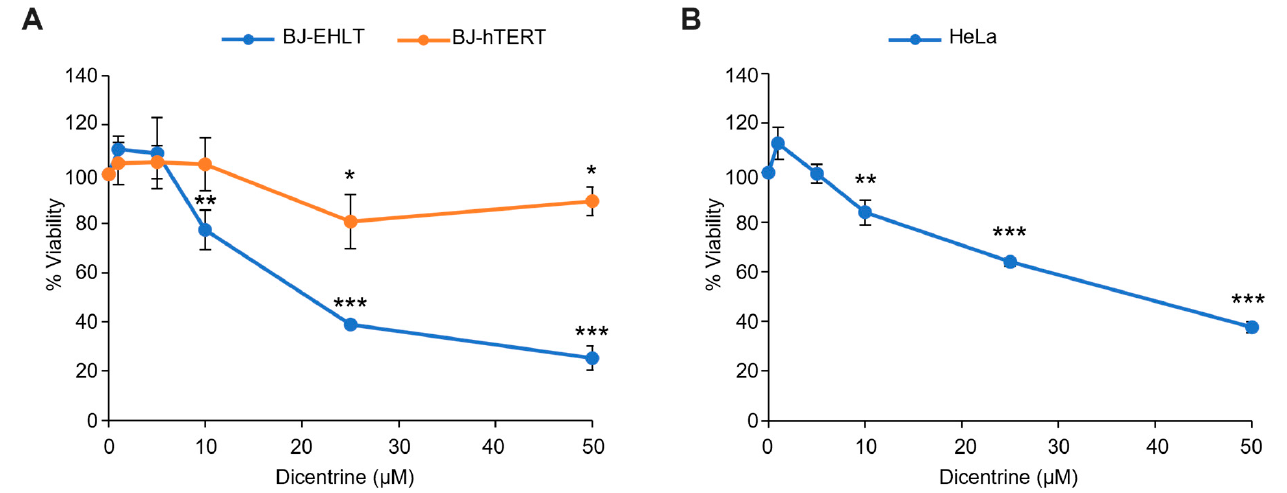
Figure 9. Effect of Dicentrine on cell viability. ( A ) BJ-EHLT (blue line) and BJ-hTERT (orange line) fibroblasts or ( B ) HeLa cells were treated for 72 h with increasing doses of Dicentrine (1, 5, 10, 25 and 50 µ M) or with DMSO (negative control). Cell viability was determined with a colorimetric crystal violet assay. Results are expressed as the percentage of viable cells over the negative control. Histograms show the mean values ± SD of three independent experiments. * p < 0.05; ** p < 0.01; *** p < 0.001.